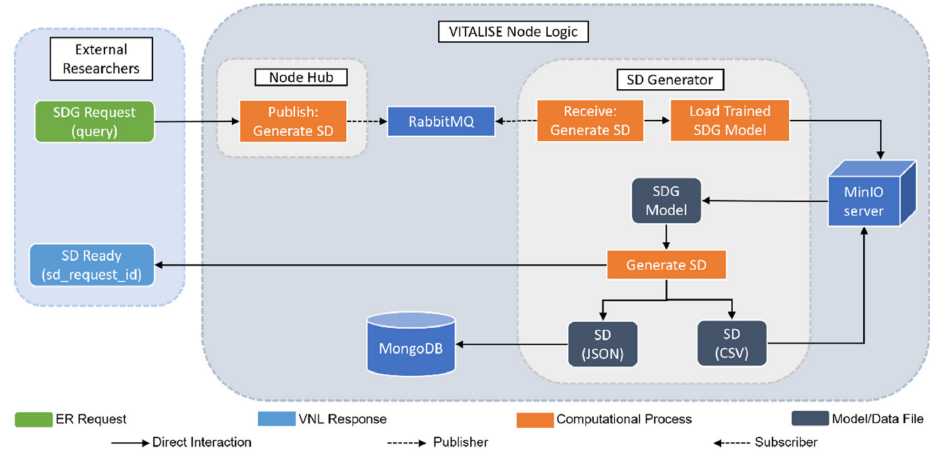
Figure 4. SDG workflow.